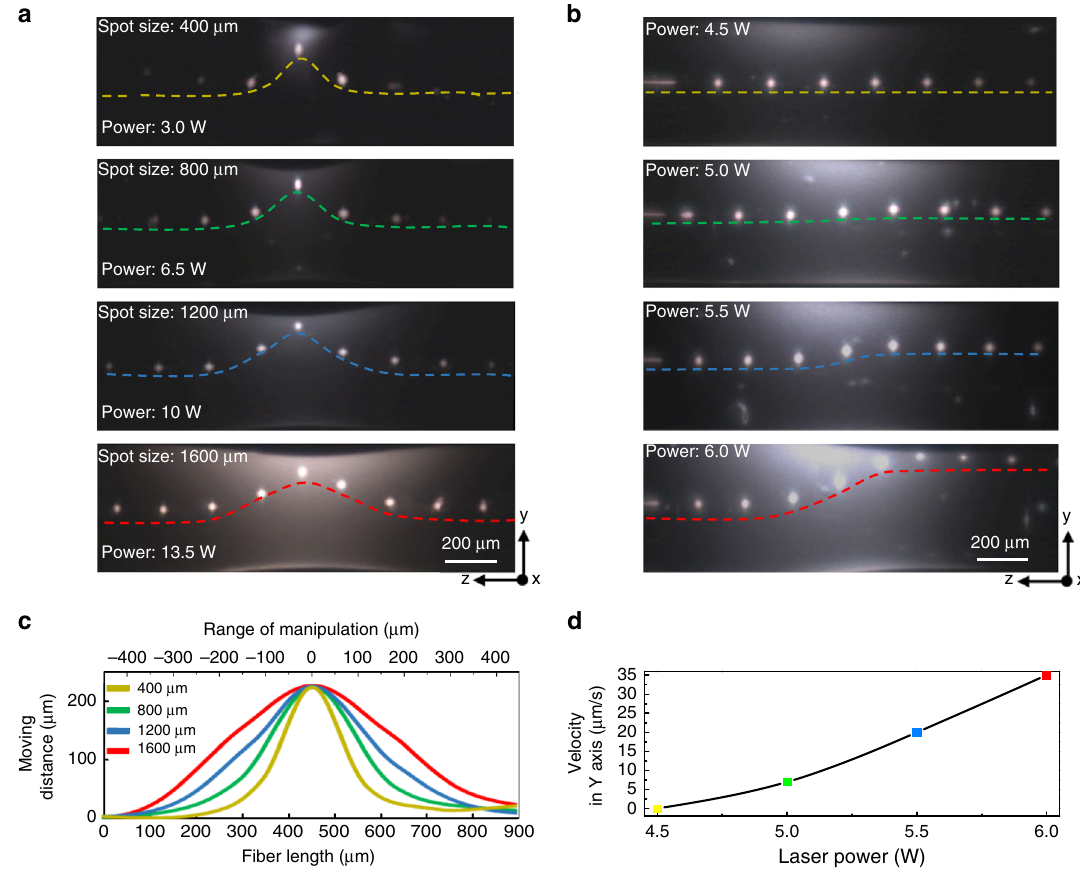
Fig. 2 Characterisation of the laser induced thermocapillary convection and particle manipulation. a Laser spot size-controlled radius of thermocapillary convections for single and multiple particles migration. By increasing the laser spot size from 400 to1600 μ m with laser power from 3 W to 13.5 W, the radius of the thermocapillary convection increases constantly. The range of the fl ow can achieve the migration of a single particle with small spot size and multiple particles with a large spot size. b Particles migration velocity pro fi les with different laser powers. The silica fi bres are embedded with germanium particles with the diameter of 16 μ m and distribution period of 95 μ m. Fibres are fed into a CO 2 laser beam at 50 μ m s − 1 . The migration velocity increases with the increased laser power, and the germanium particle lines are relocated at different positions according to the different trapping velocities. In a and b , the laser is focused at the centre of the top surface. c Variation of the thermocapillary convention ’ s range with different laser spot sizes. d Variation of particles migration velocity as a function of laser the laser power and beam spot size to investigate the controllability of the manipulations in terms of three key parameters for particles ’ manipulation: the number of particles being moved, the particles migration velocity and the moving direction. First, as shown in Fig. 2a, the number of moved particles is relevant to the laser spot sizes and laser powers, which directly determine the range of the thermocapillary convection. Smaller laser spot size shortens the liquidised cladding length and induces a limited range of thermocapillary convection, which is suitable for manipulating single particle or a small group of particles. The number of migrated particles keeps increasing with increasing the laser spot size and power because larger laser spot size results in a longer liquidised cladding length and larger range of thermocapillary convection, which involves more particles into the manipulation